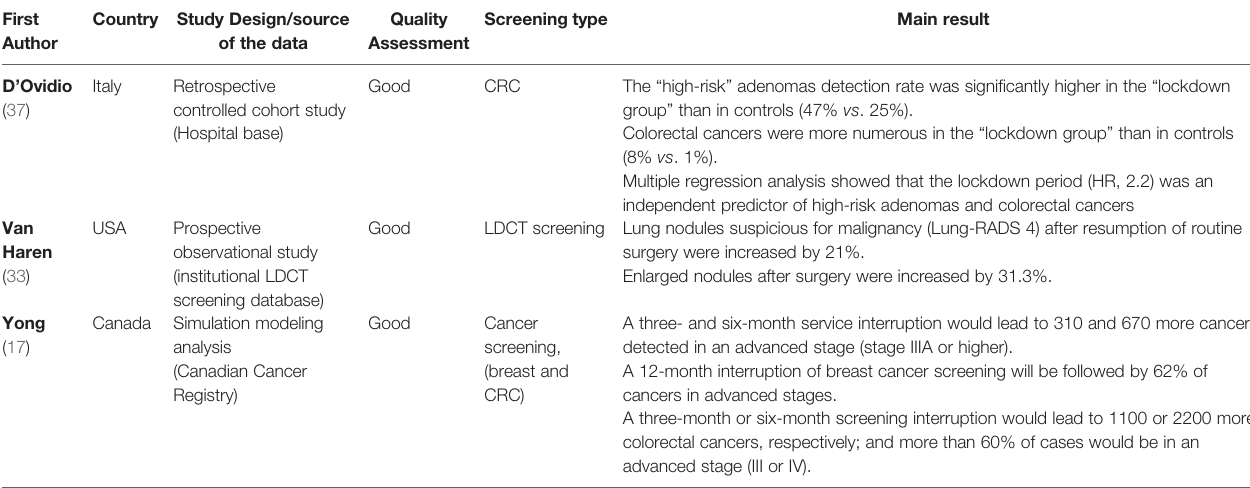
TABLE 3 | Impact of lockdown-related delays in medical care on tumor stage at the time of